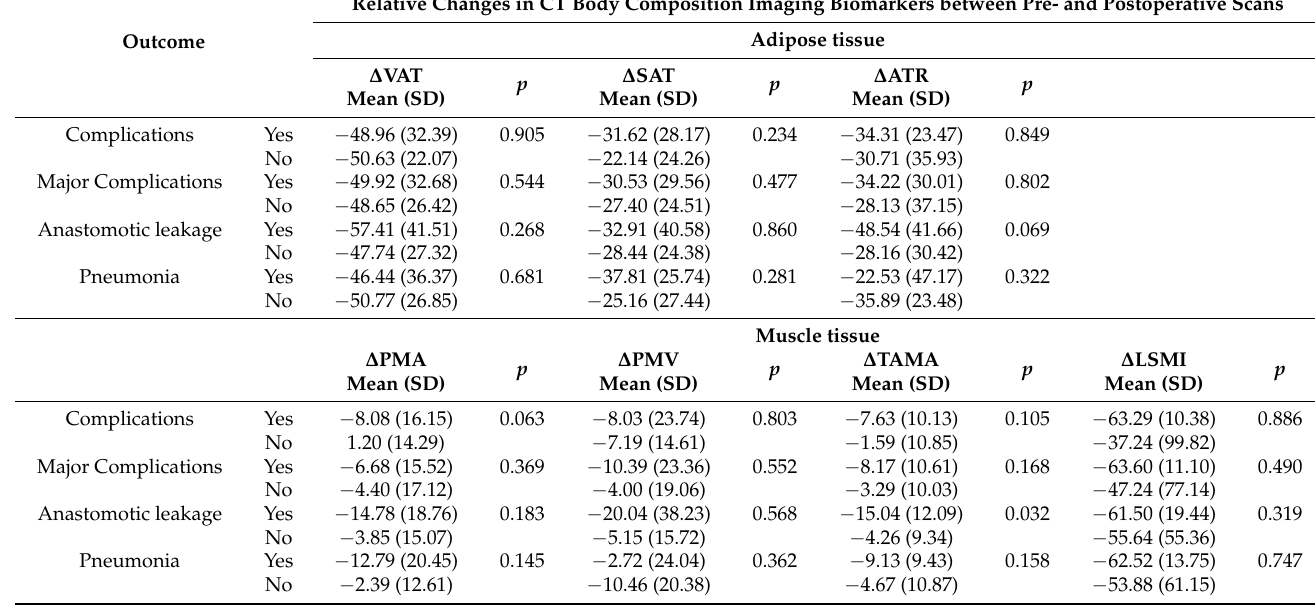
Table 5. Correlation analysis of relative changes in CT body composition imaging biomarkers to postoperative complications.